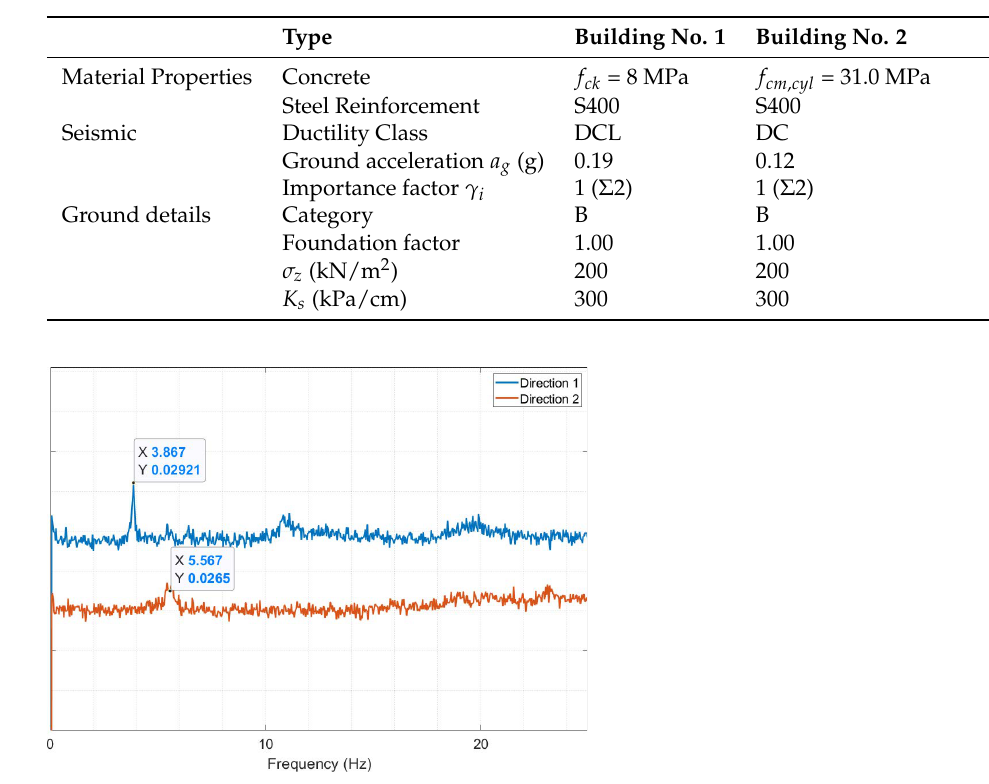
Table 2. Details for building case studies 1 and 2.